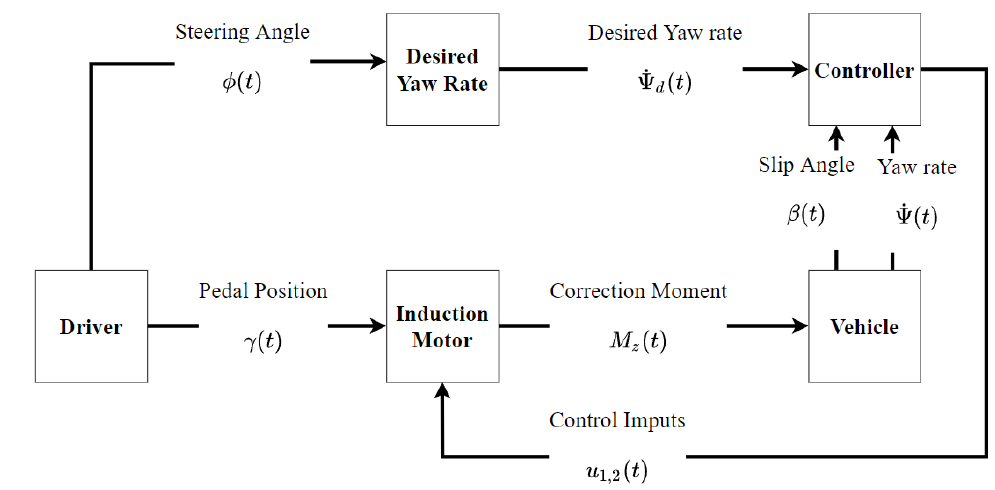
Figure 5. Basic control